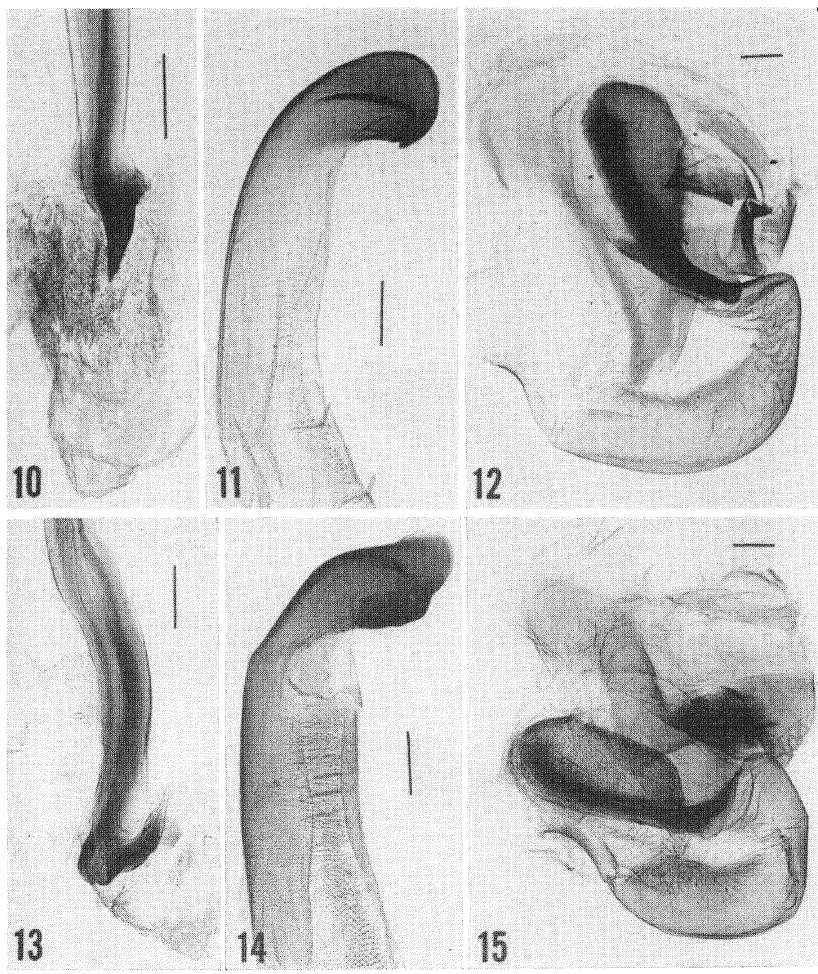
Figs. 10-15. Poeciloderrhis spp. 10-12. (1501, L). P. proxima. Orns- k61dsvik, Sweden; tergal glands in Figs. 48, 49. (Adventive) (det. Princis). 13-15. (58, USNM). P. erticalis. Serra Carac, a, Matto Grosso, Brazil; adult and tergal glands in Figs. 50-52. (det. Gurney). (The tip of L2d was inadvertantly cut off.) (scale 0.2